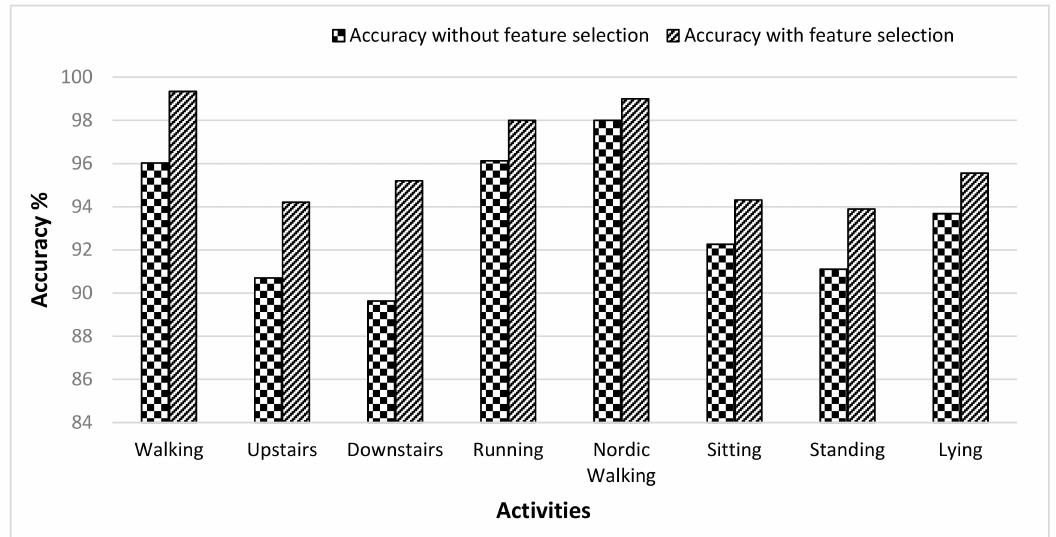
Figure 6. User recognition accuracy of RF, SVM, and DT classifiers for selected activities in the PAMAP2 dataset.